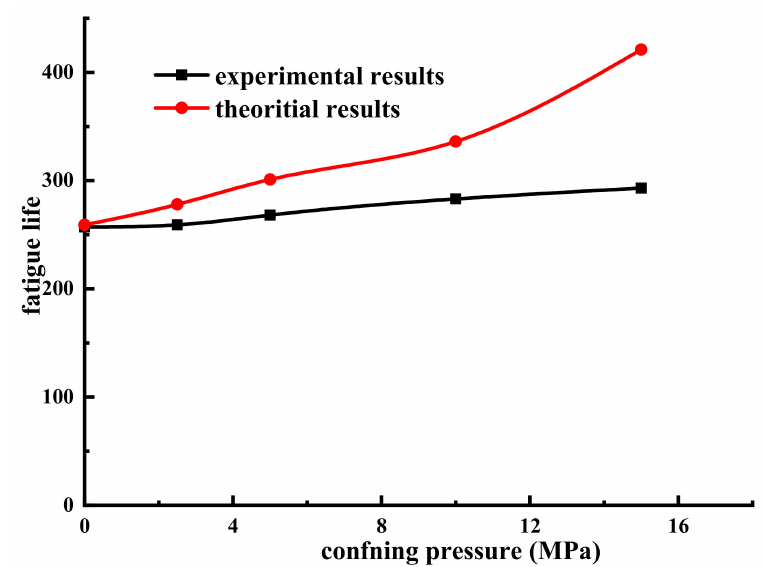
Figure 14. The fatigue life of sandstone varies with confining pressure when the upper limit stress ratio is 0.9 ( σ max = 0.9 σ p ).